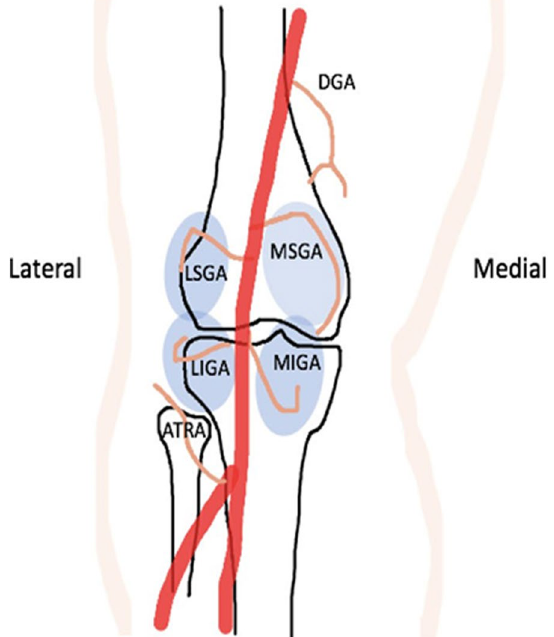
Fig. 1 Illustrative diagram shows the classic anatomy of the genicular arteries. DGA: Descending genicular artery; (MSGA) medial superior genicular artery, (MIGA) medial inferior genicular artery, (LSGA) lateral superior genicular artery, (LIGA) lateral inferior genicular artery and (ATRA) anterior tibial recurrent artery